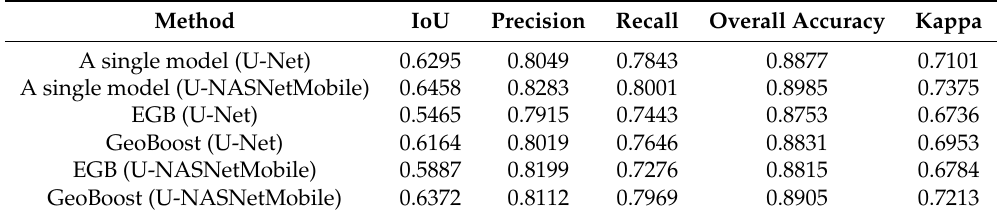
Table 2. Results for the comparison of different methods. The result of a single model is obtained by training a net with all the available training data x 0 , x 1 , x 2 , and x 3 from four areas. EGB is short for the end-to-end gradient boosting